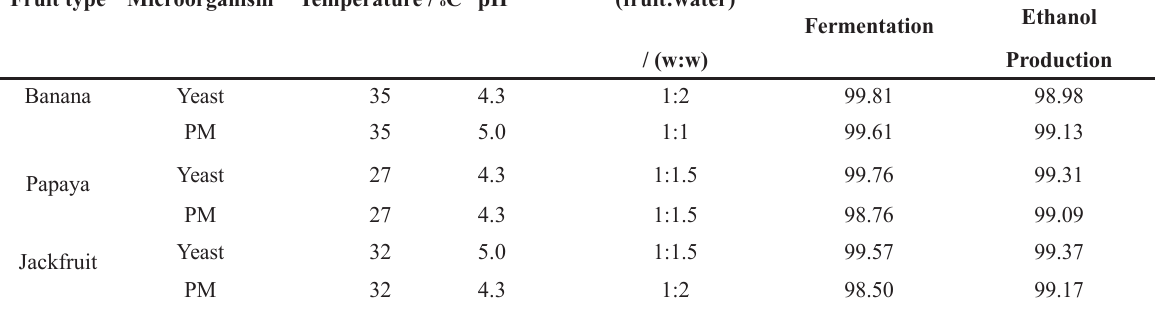
Table 5: Optimum fermentation parameters and correlations.